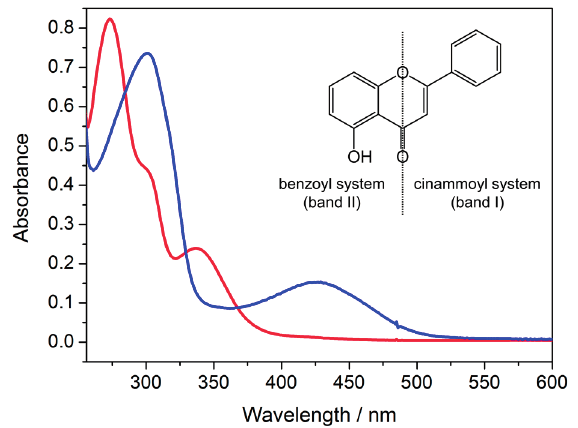
Figure 3. UV-Vis spectra of dimethylsulfoxide (DMSO) solutions of 43.1 μ M primuletin